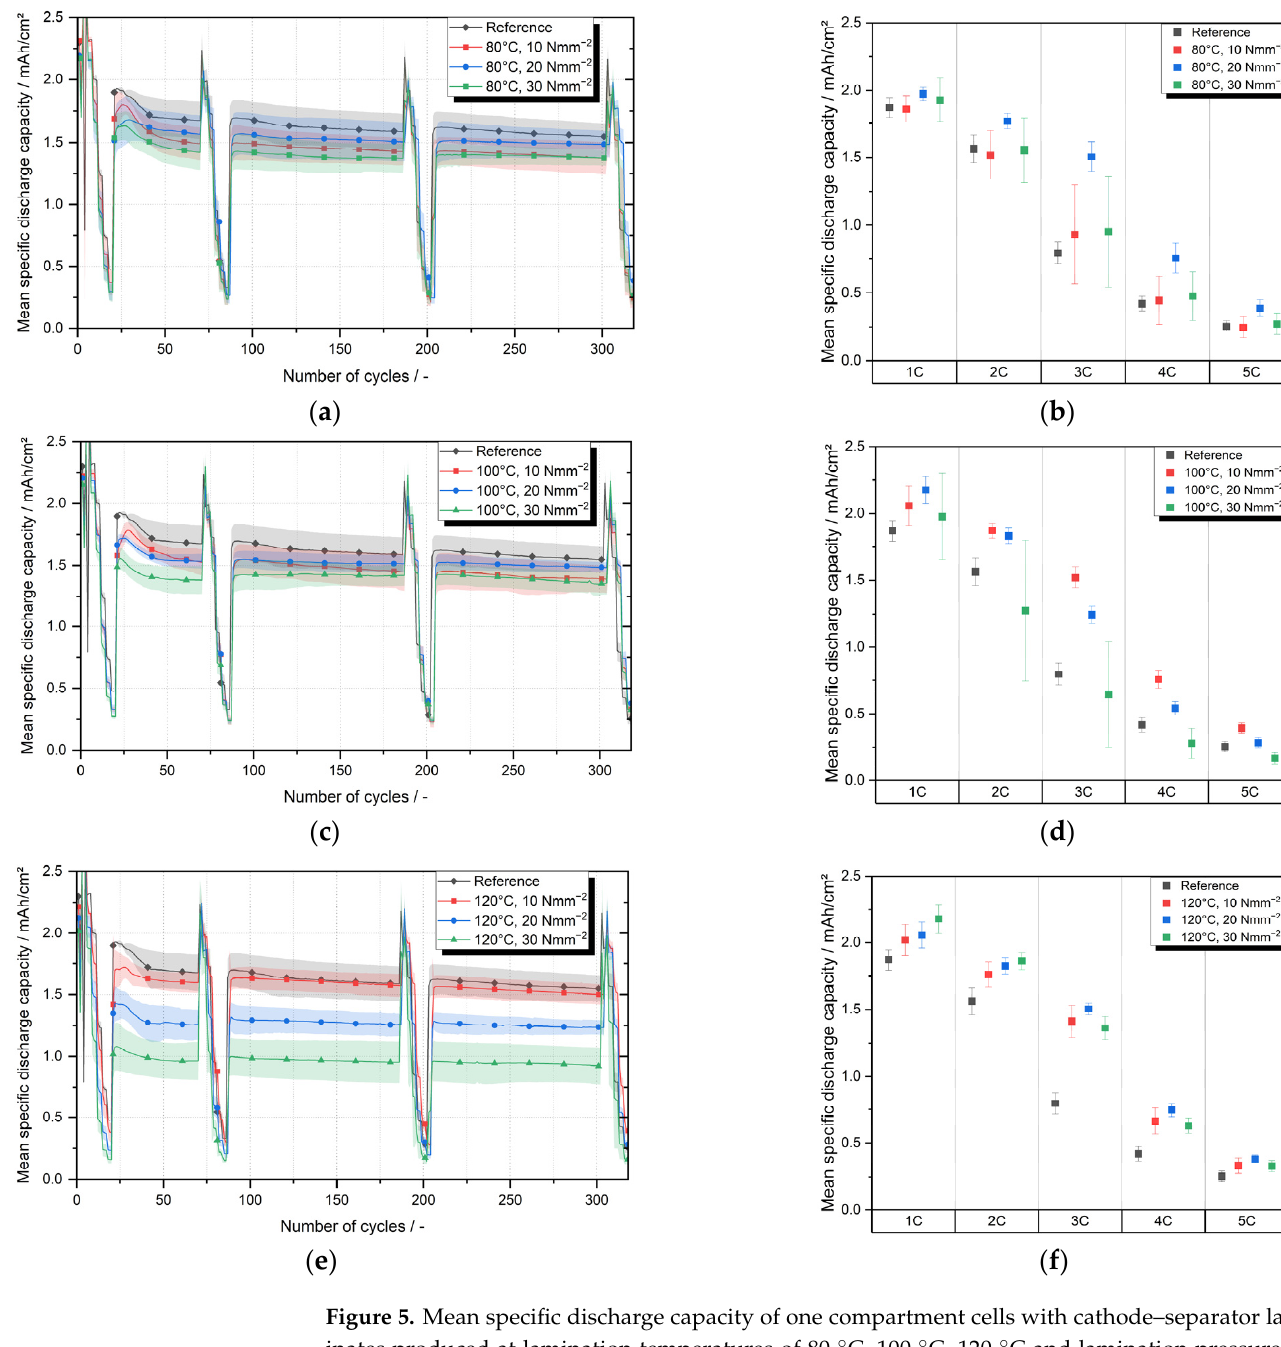
0.924 mAh cm − 2 respectively. Compared to the reference value, this corresponds to 80% and 60%, respectively.